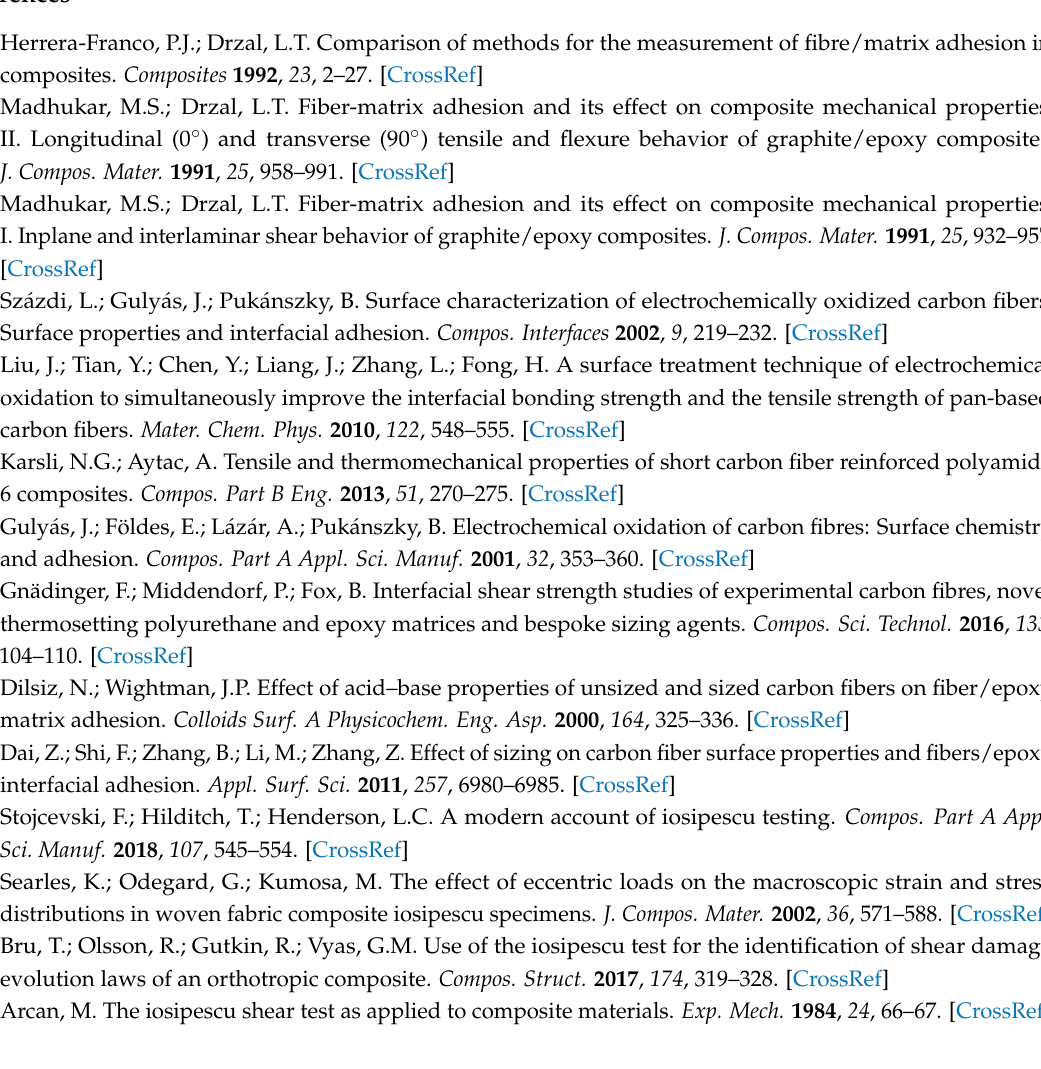
s1, Figure S1: Aluminium male section for Iosipescu moulds, Figure S2: Silicon SFFT mould with clear resin and fibers tensioned across the center, Figure S3. Example of ongoing testing of epoxy resin and tow sizes with other resin systems. (2,2-Bis[4-(glycidyloxy)phenyl]propane/4,4 (cid:48) -Methylenedianiline) DGEBA/DDM. Author Contributions: Conceptualization, L.C.H. and F.S.; Methodology, M.K.S., C.L.A., D.J.E., J.D.R.;